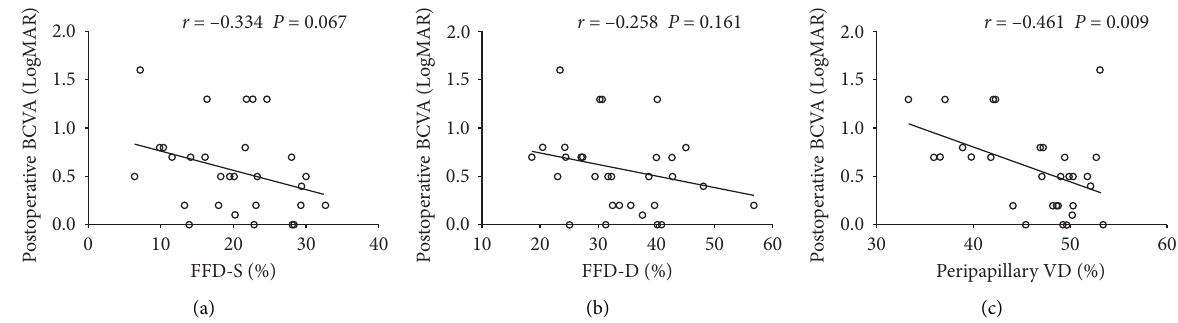
Figure 2: Scatterplots of associations between the postoperative (a) superficial foveal flow density (FFD-S), (b) deep foveal flow density (FFD-D), (c) peripapillary vessel density (VD), and postoperative best-corrected visual acuity (BCVA) three months after surgery.